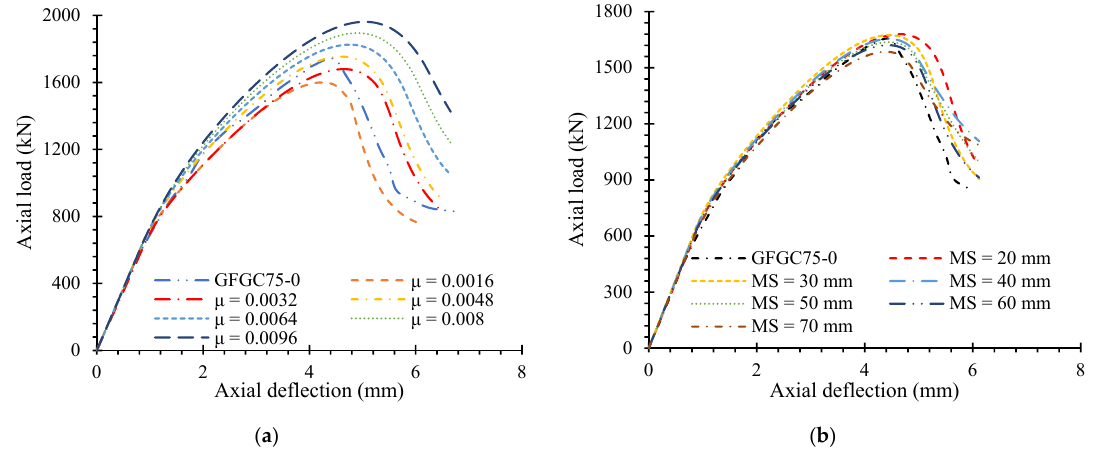
Figure 8. Effect of calibration on the behavior of the control sample ( a ) viscosity parameter ( b ) mesh size.